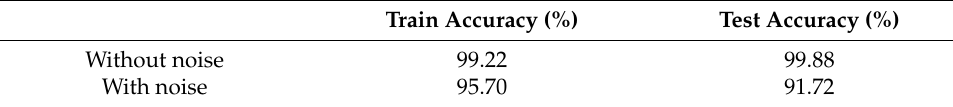
Table 2. Neural network training result for simulation.